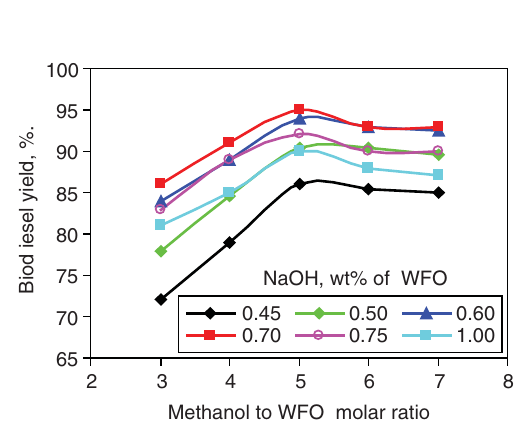
Fig. 2. The effect of NaOH concentrations on the biodiesel yield as a function of the methanol to oil molar